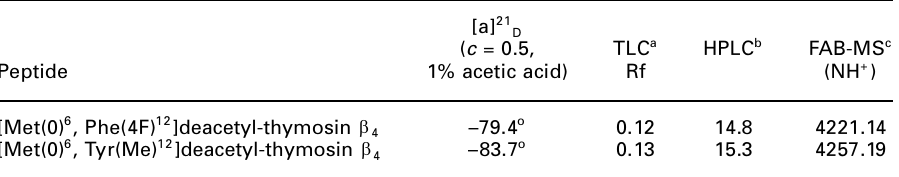
Table 1. Characterization of synthetic [Met(0) 6 , Phe(4F) 12 ]deacetyl-thymosin b 4 and [Met(0) 6 , Tyr(Me) 12 ]deacetyl-thymosin b 4